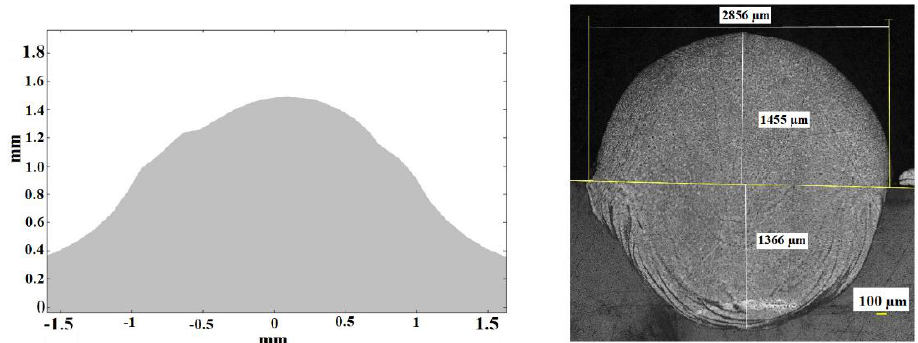
Figure 12. Theoretical ( left ) and experimental ( right ) cross sections corresponding to test 1. Note that in the case of the experimental one the dilution under the substrate is shown while the theoretical one represents exclusively the external part of the consolidated material, from the top of the substrate.